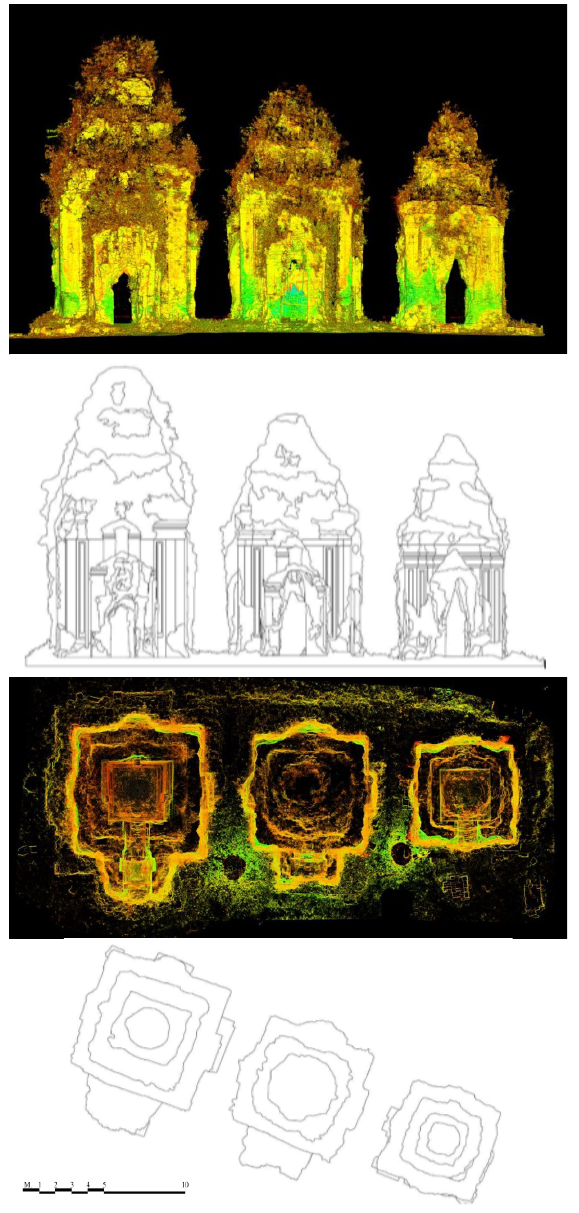
Figure 14. The Khuong My survey and graphical outputs Another technique applied to produce point clouds has been based on digital photogrammetry by means of Structure from Motion (SfM) algorithm applied by Agisoft Photoscan ( http://www.agisoft.ru/products/photoscan ). The software is an advanced image-based 3D modeling solution based on the latest multi-view 3D reconstruction technology. It operates on arbitrary images that can be taken from any positions, with the only constrain that the object was visible on at least two photos. Both image alignment and 3D model reconstruction is fully automated (Doneus et al., 2011).